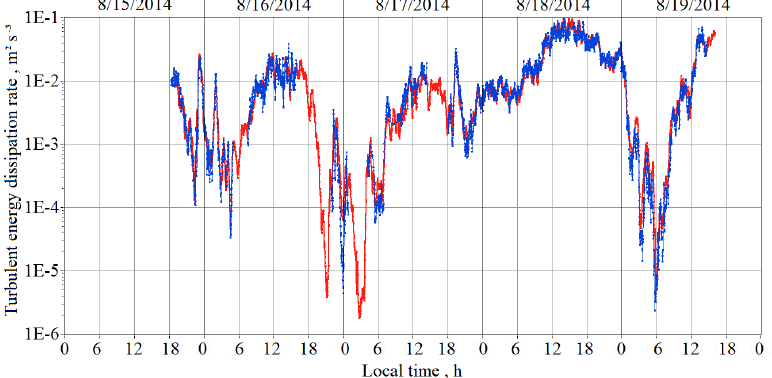
Figure 4. Time series of the turbulence energy dissipation rate obtained from measurements by the sonic anemometer (red curve) and the Stream Line lidar (blue curves) at a height of 43m.